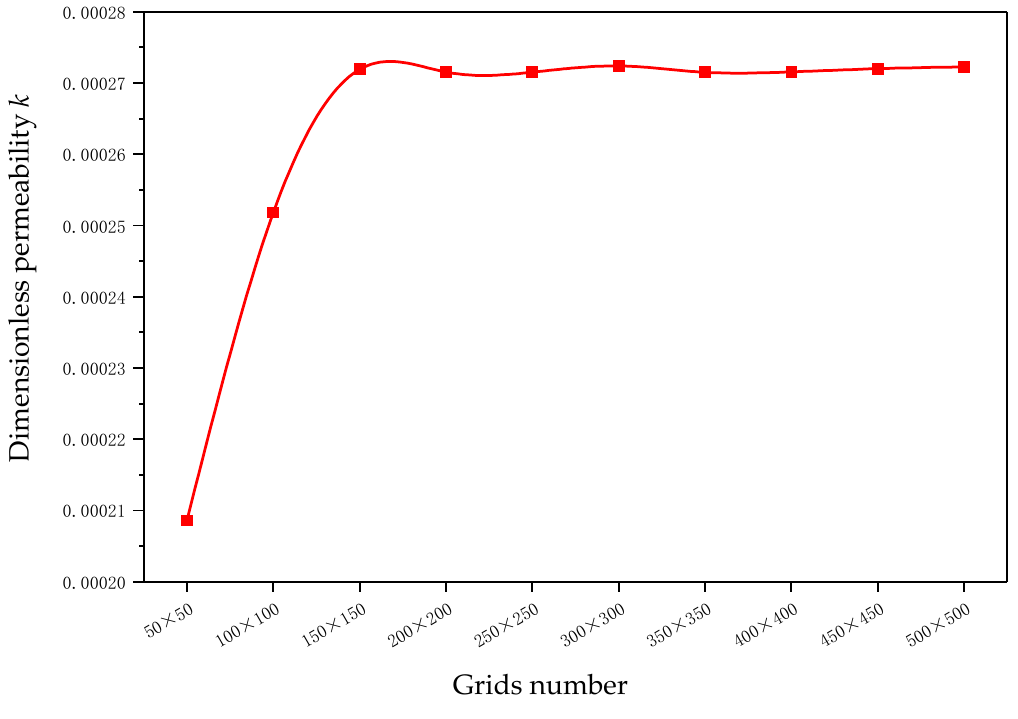
Figure 13. Mesh sensitivity study for dimensionless permeability.